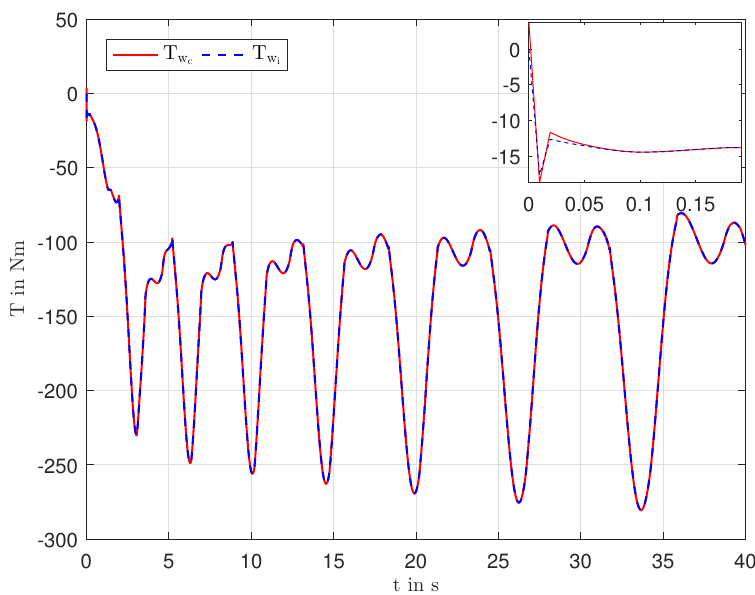
Figure 7. Desired and actual winch